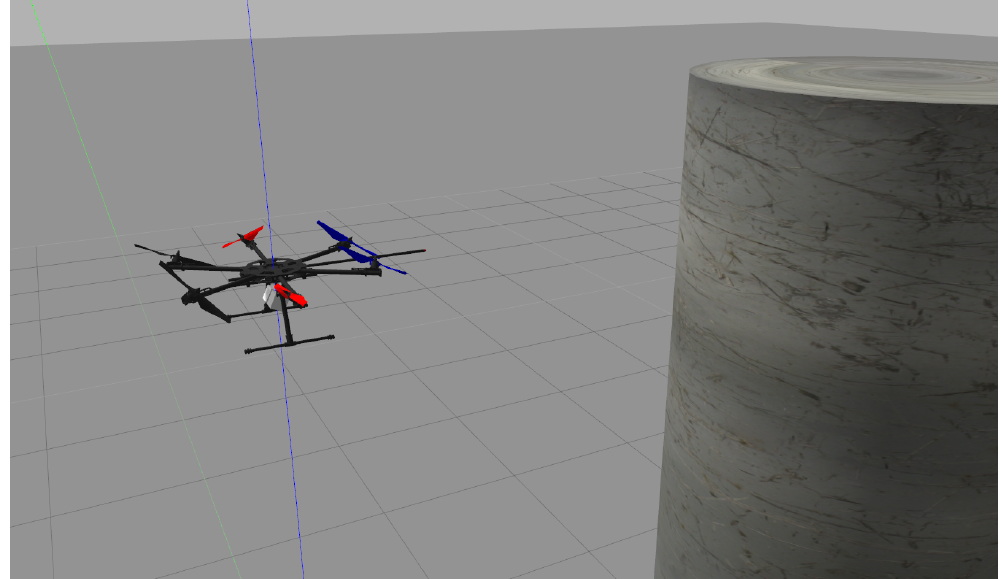
Figure 3. Our simulation environment: A drone with a stereo camera can create its flight path online, in order to make sure that the object of interest can be fully 3D reconstructed.